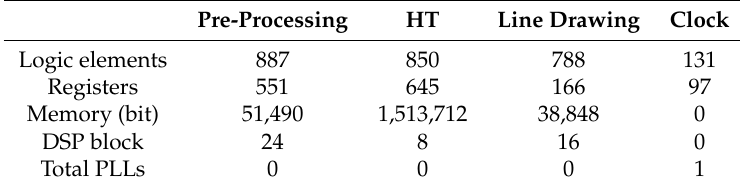
Table 2. Hardware resource usage of each module in the prototype system for line